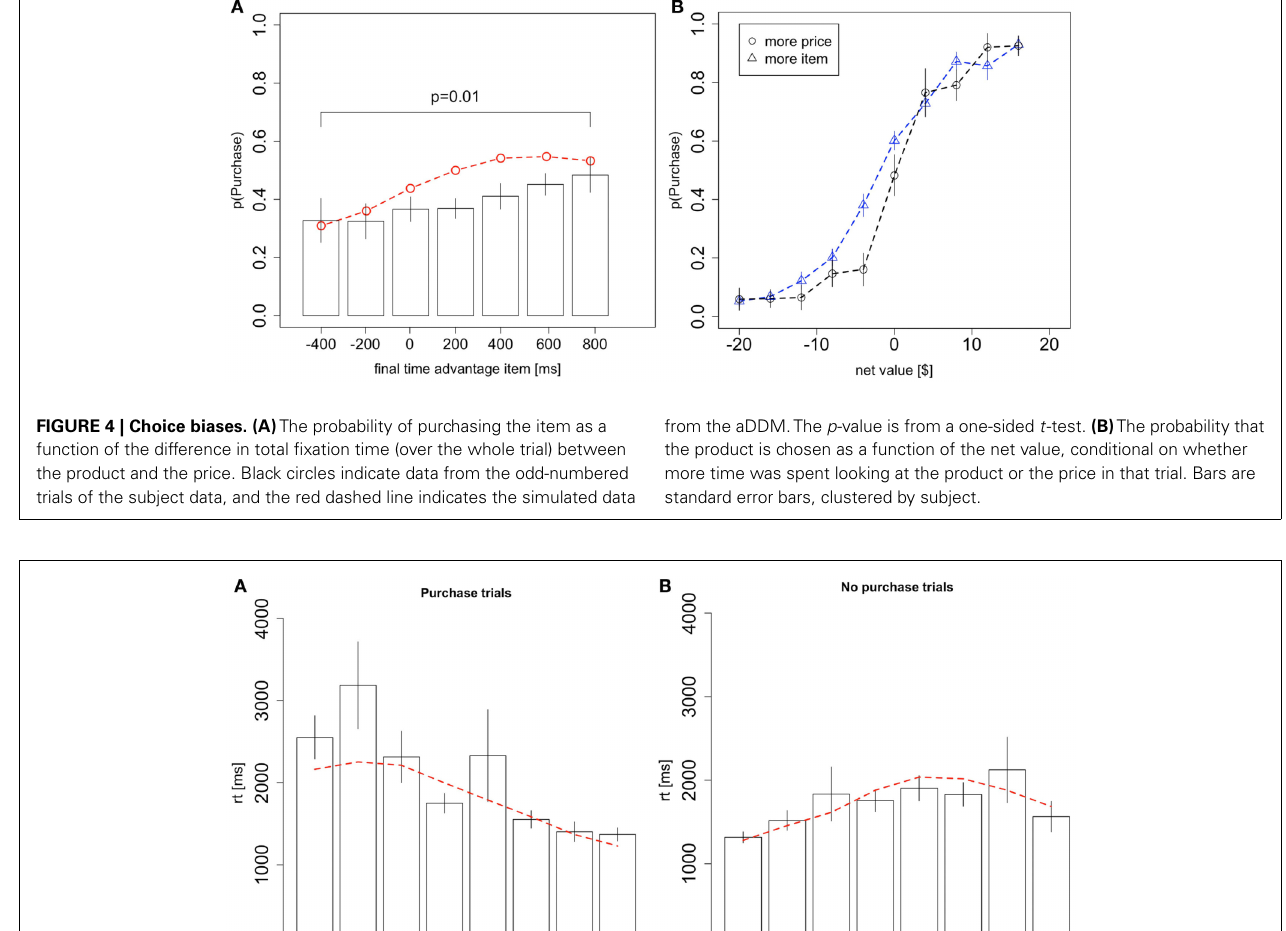
FIGURE 5 | Reaction times conditional on choice. (A) Reaction times as a function of the net value, conditional on purchasing the product. (B) Reaction times as a function of the net value, conditional on not purchasing the